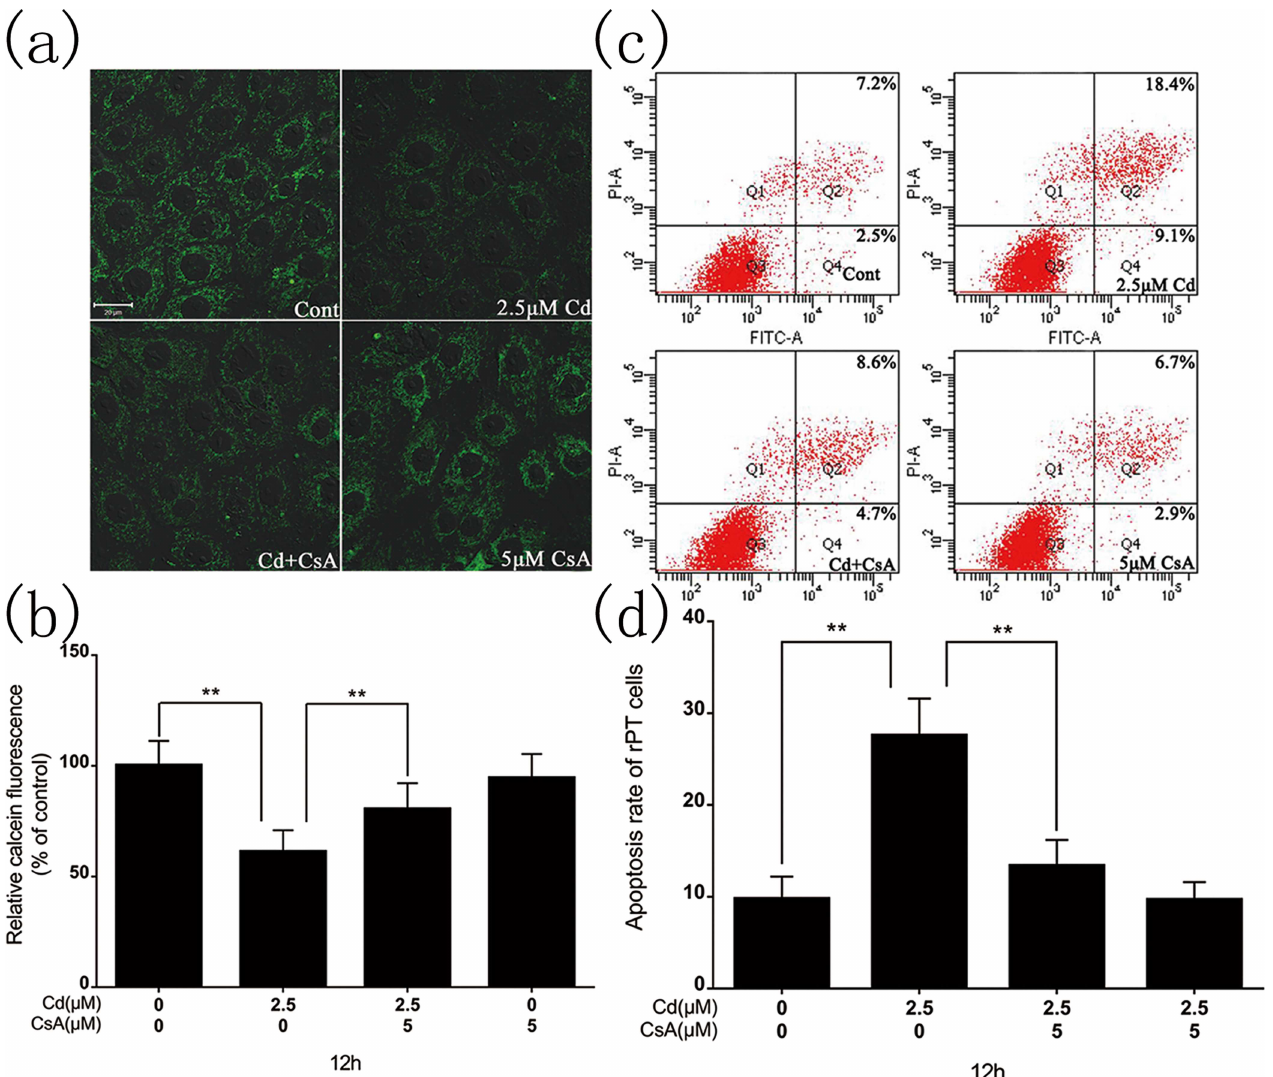
Fig 2. Confocal microscopy of MPTP opening after 12-h cadmium (2.5 μ M) treatment in the absence or presenceof CsA (5 μ M). (a) Representative confocalimages of cadmium-induced rPT cells. (b) Quantificationof calcein fluorescence. The calceinfluorescence values were quantifiedrelativeto the control, where the fluorescence value was set at 100%. (c) Flow cytometry detectionof the apoptosisrate after 12-h cadmium (2.5 μ M) treatment in the absenceor presence of CsA (5 μ M) with annexinV–FITC/PI staining.(d) Percentage of apoptoticcells. Results are the mean ± SD of three separate experiments, each performed in triplicate (n = 9). ** P < 0.01 as compared to